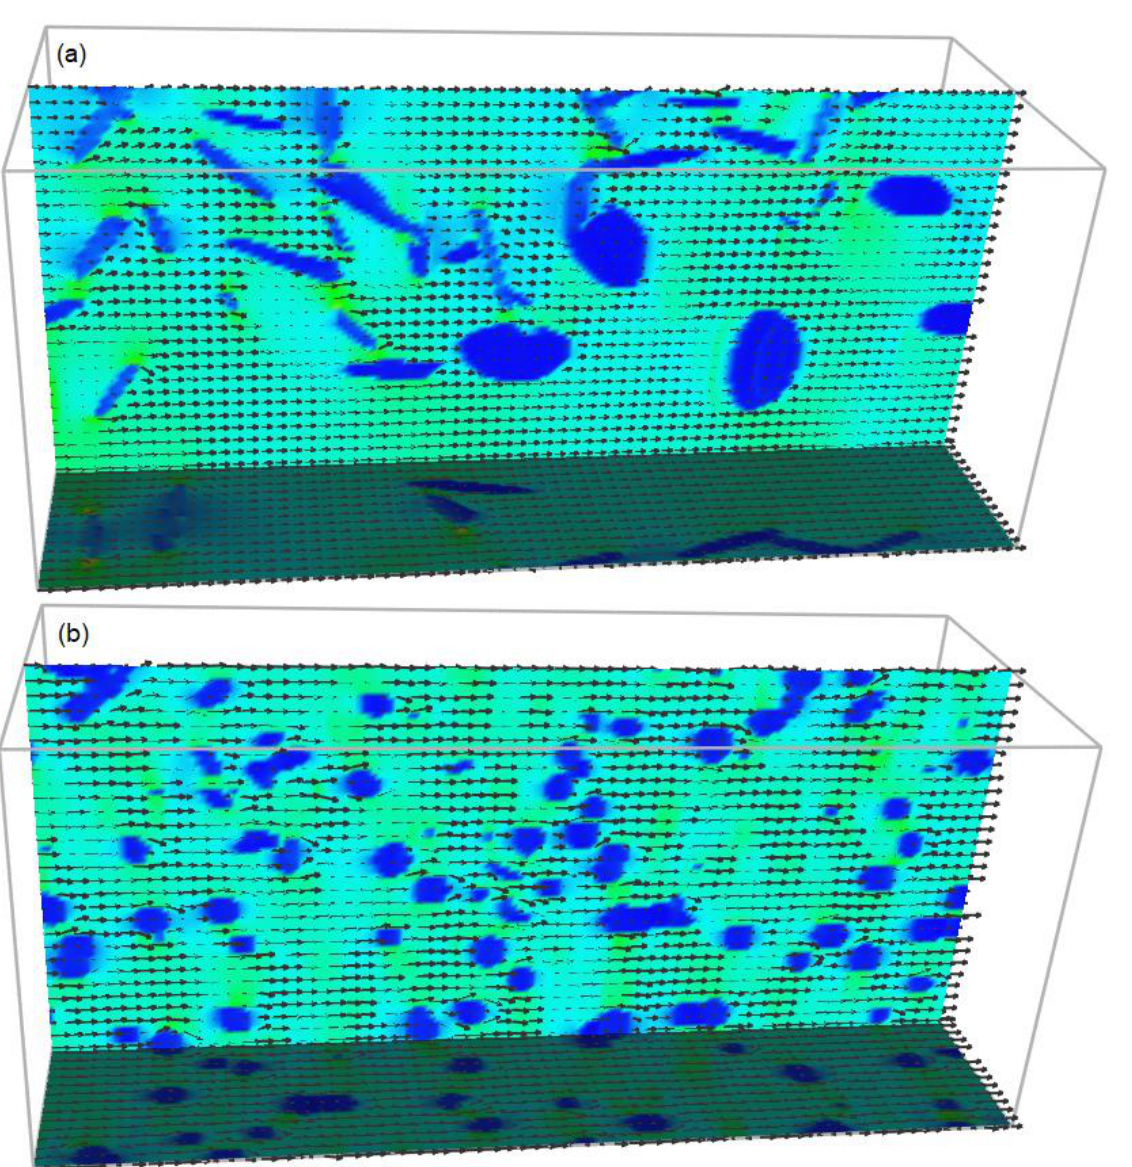
Figure 3. The electric current distributions in a high-conductive matrix containing low-conductive ( a ) plate shapes and ( b ) broken and spheroidised grains.